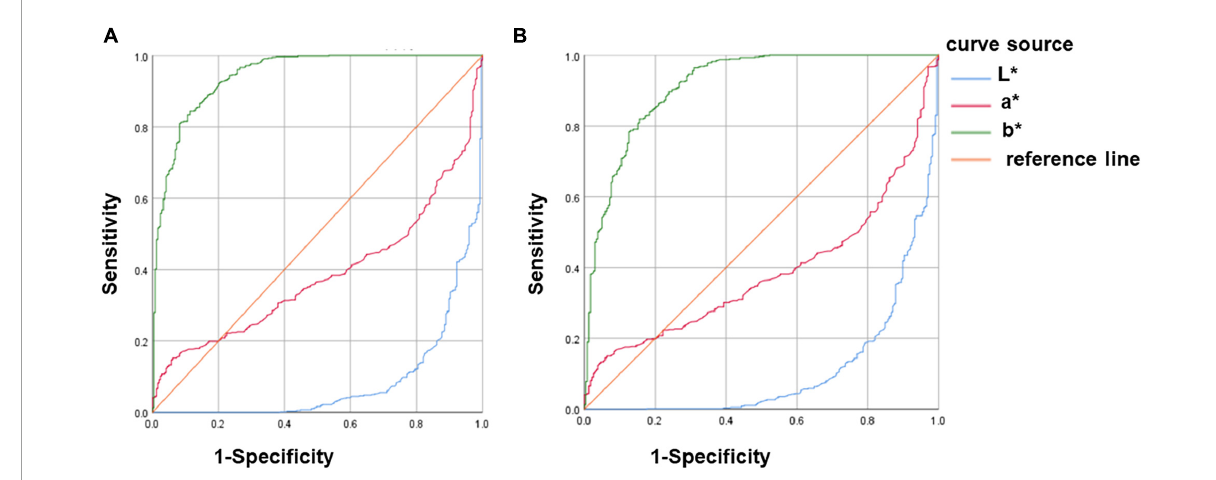
FIGURE4 ROC curve analysis of urine colour L*a*b* for assessing hypohydration. (A) Hypohydration was defined as Usg ≥ 1.020. (B) Hypohydration was defined as Uosm ≥ 700mmol/kg; Uosm, urine osmolality; and Usg, urine specific gravity.